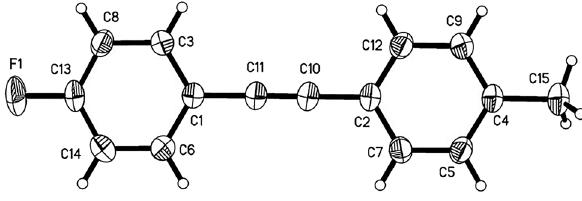
Table  : Data collection and handling.